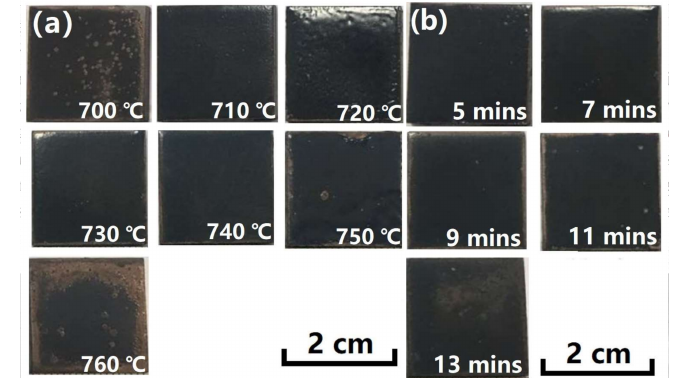
Figure 3. Optical macro-morphologies of the enamel coating fabricated at different sintering temperature and time. ( a ) Samples sintered at different temperature for 5 min; and, ( b ) samples sintered at 730 ◦ C for different